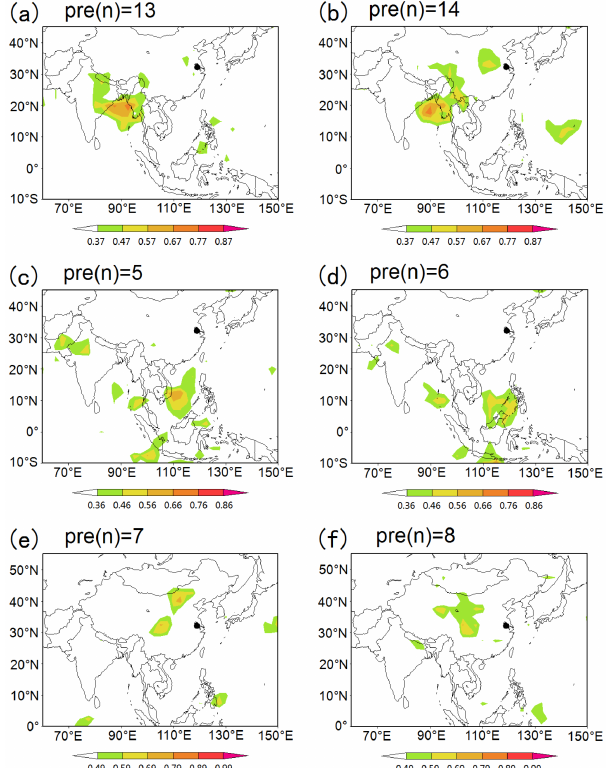
Figure 9. Spatial correlation between daily δ 18 O in precipitation and OLR at n days prior to the rainfall date. Spatial correlation be- tween δ 18 O in precipitation and OLR at 13 days (a) and 14 days (b) prior to the rainfall date for stages 1 and 4. Spatial correlation be- tween δ 18 O in precipitation and OLR at 5 days (c) and 6 days (d) prior to the rainfall date for stage 2. Spatial correlation between δ 18 O in precipitation and OLR at 7 days (e) and 8 days (f) prior to the rainfall date for stage 5. For all maps, only areas with correla- tions significant at the 0.05 level are shown. The study site Nanjing is marked with a black